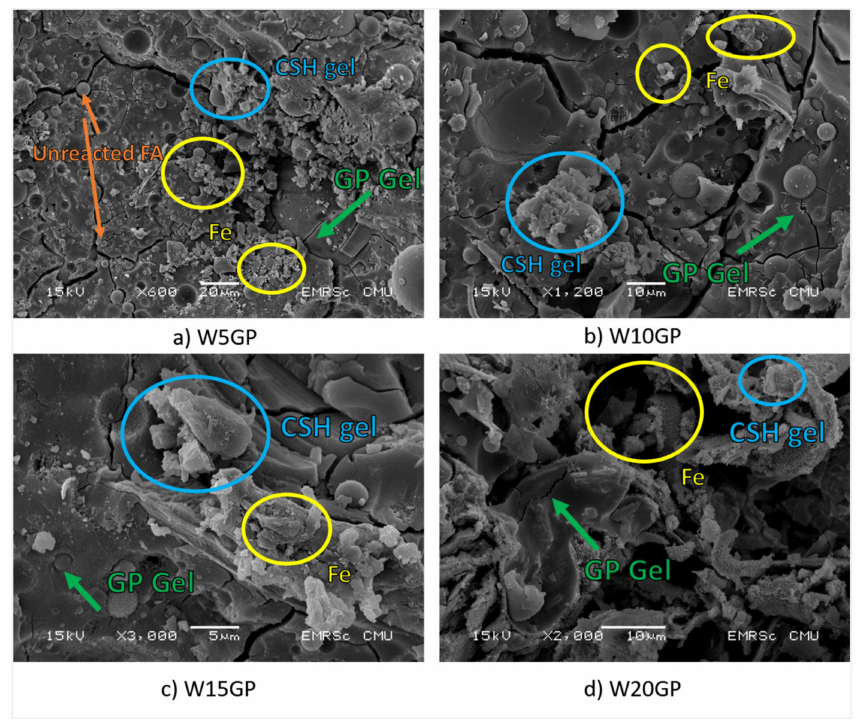
Figure 11. SEM figures of Na 2 [Fe(OH) 4 ] existence. ( a ) W5GP at 600 × magnification ( b ) W10GP at 1200 × magnification ( c ) W15GP at 3000 × magnification ( d ) W20GP at 2000 ×